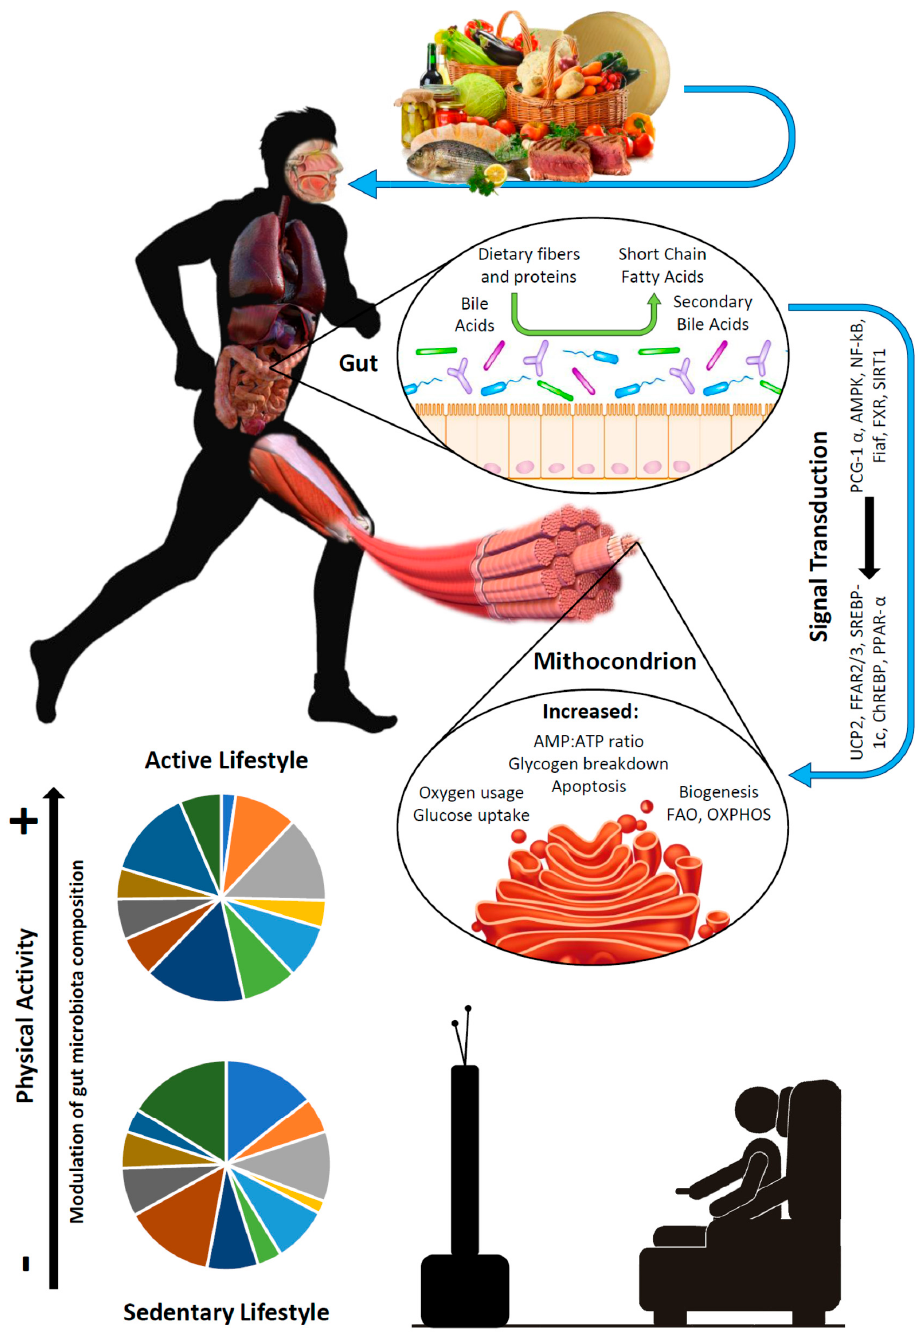
Figure 1. Overview of the putative physiopathological mechanisms that put gut microbiota composition at the cross-road between nutrition and muscle function. Diet influences the microbiota composition; in turn, microbiota metabolizes some nutrients, including fibers and proteins, into mediators, such as short-chain fatty acids, which enter the systemic circulation. These mediators have a known influence on myocytes, and namely on their mitochondria, through multiple signaling pathways that result from the modulation of inflammation and the promotion of insulin sensitivity. The lower part of the figure also shows that physical exercise itself can modulate gut microbiota composition and represent a relevant player in these